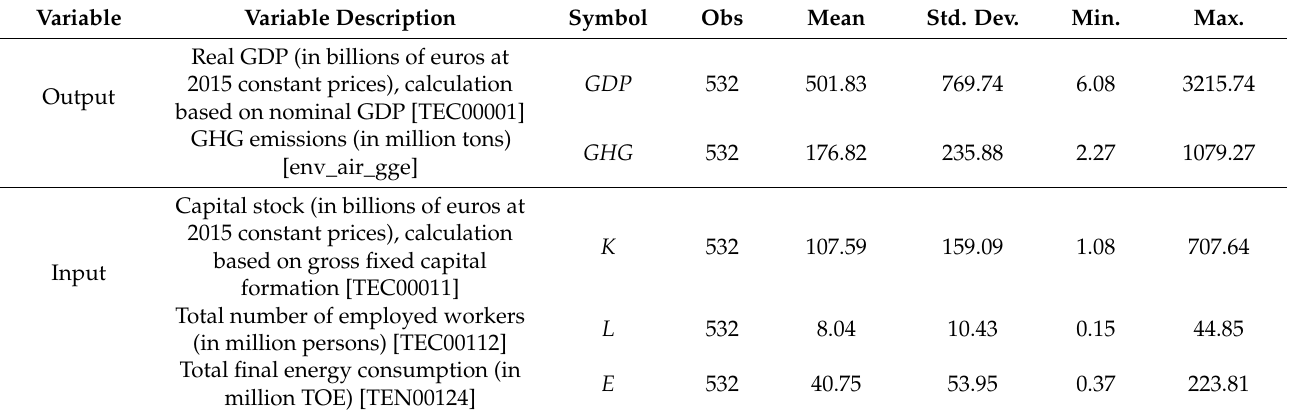
Table 1. Descriptive statistics of the